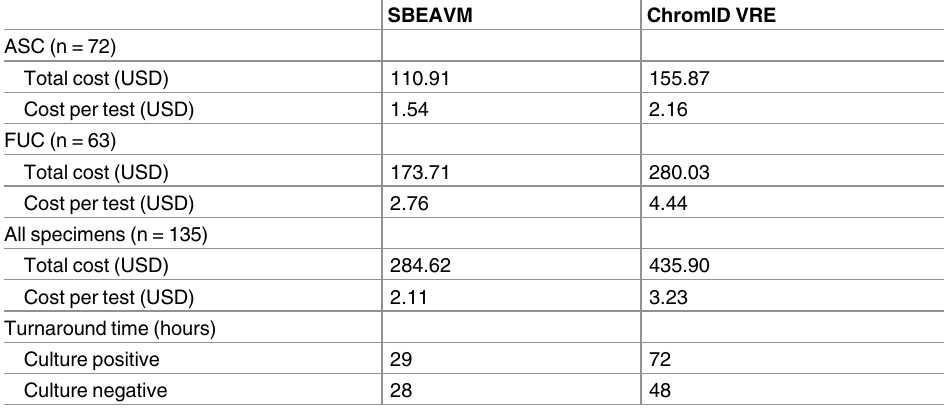
Table 3. Comparison of laboratory material costs and turnaround times between the selectiveBEAV broth plus MALDI-TOF MS (SBEAVM) and ChromID VRE methods for VRE detection in 135 specimens.